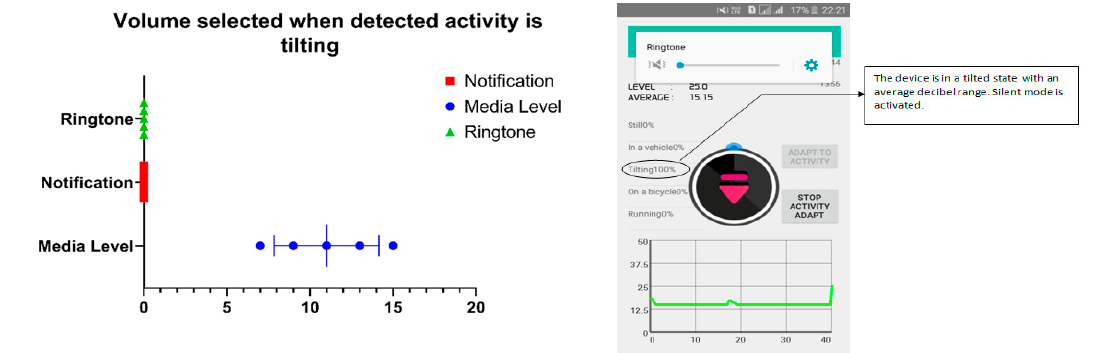
Figure 12. Volume selection during tilting.